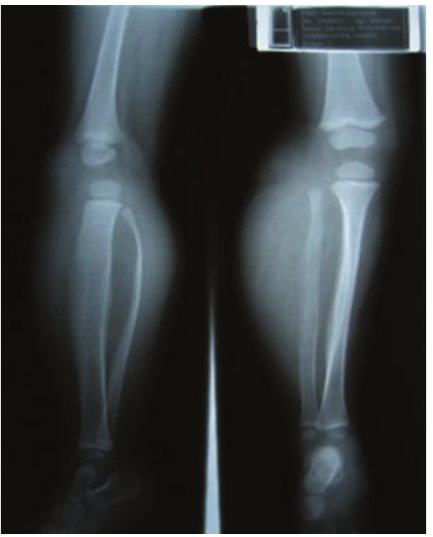
Figure 2: Plain radiograph of Case 1 showed a soft tissue mass. Both tibia and fibula were deformed, which gave an impression of a benign slow-growing